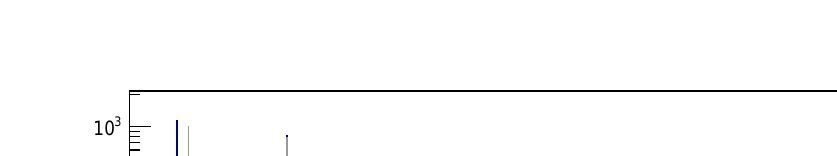
e ffi ciency as a function of position along the beam axis, W ( z ) accounts for the photon angular distribution and N p is the number of projectiles impinging the